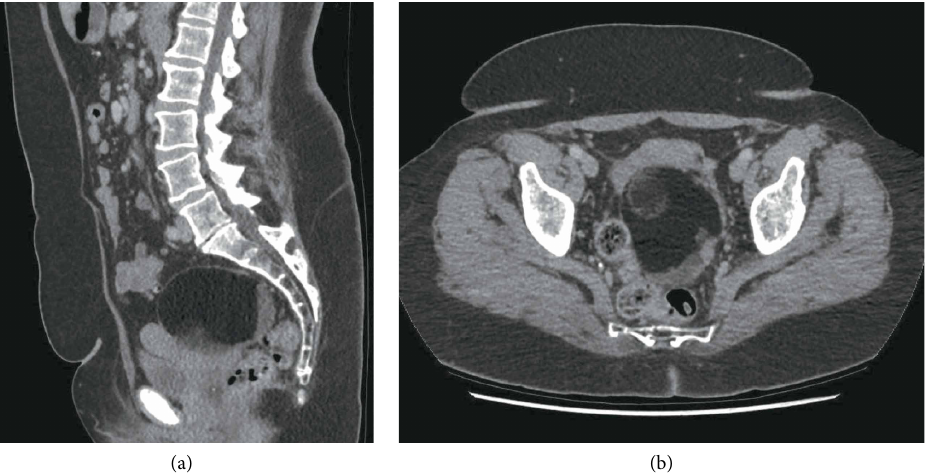
Figure 1: Preoperative CT images of the right adnexal mass.